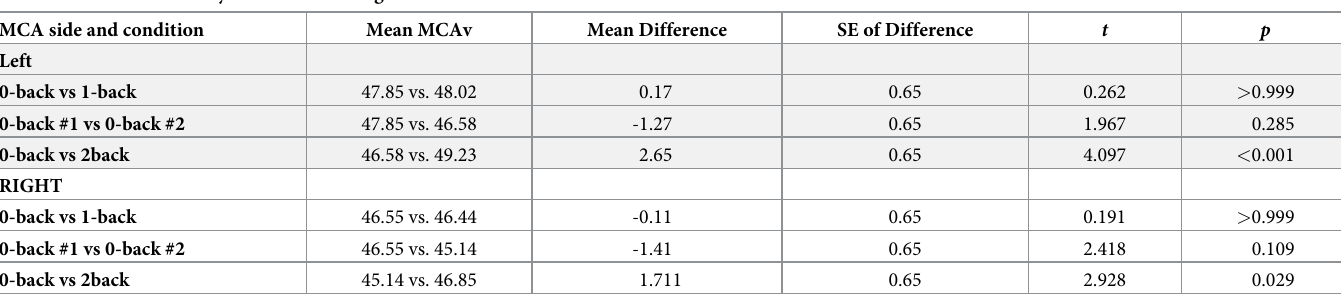
Table 2. MCA flow velocity increased with cognitive load.